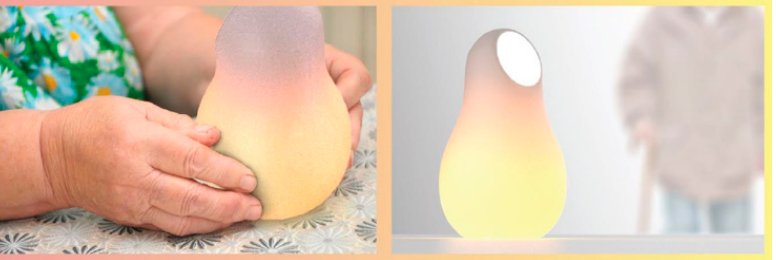
Figure 3. A soft robot that conveys telepathy. Ambi (Courtesy of Daniel Cho, RISD, Province, RI, USA, 2015).